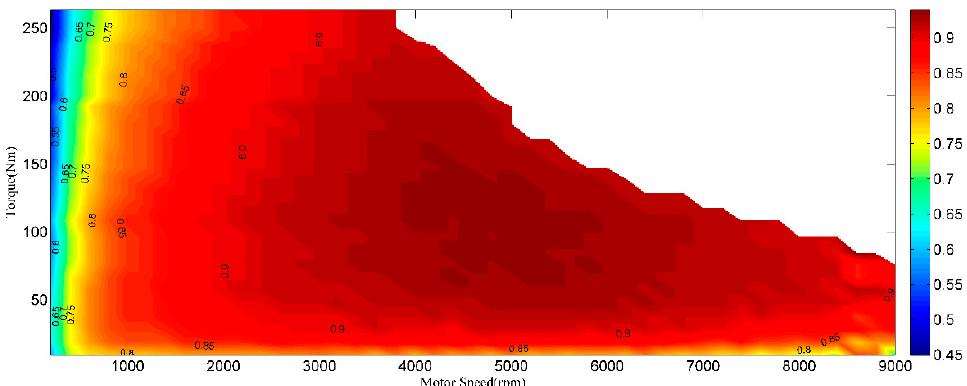
Figure 1. E ffi ciency map of the electric vehicle (EV) driving motor system. Figure 1. Efficiency map of the electric vehicle (EV) driving motor system.